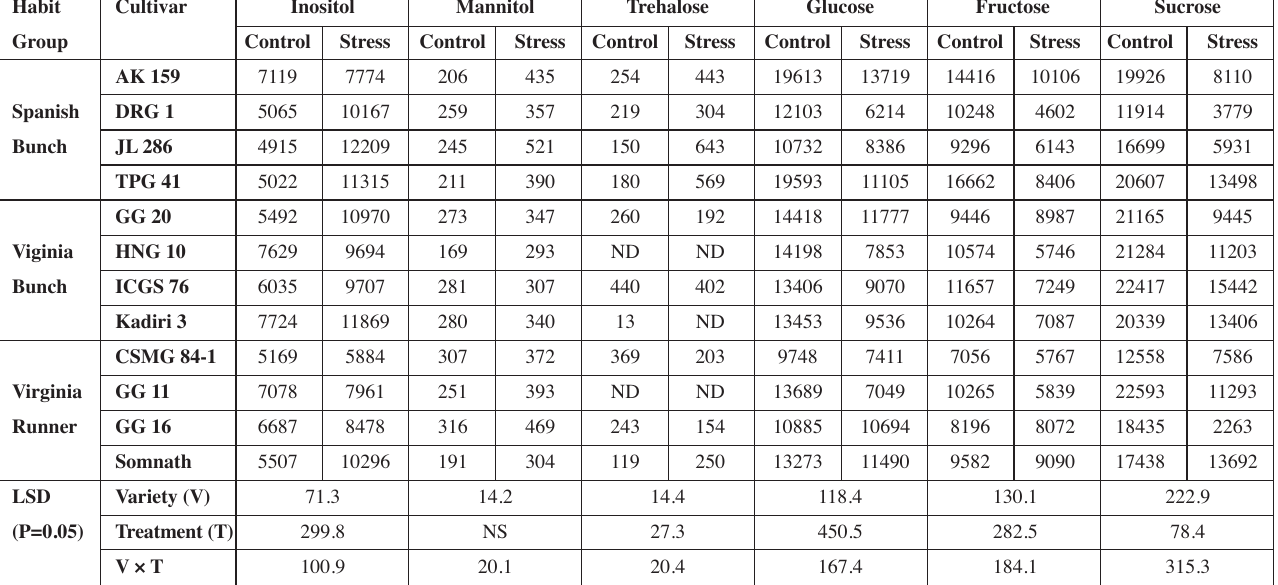
Tab. 2: Sugar profiles (ppm) of groundnut leaves during water deficit stress Habit Cultivar